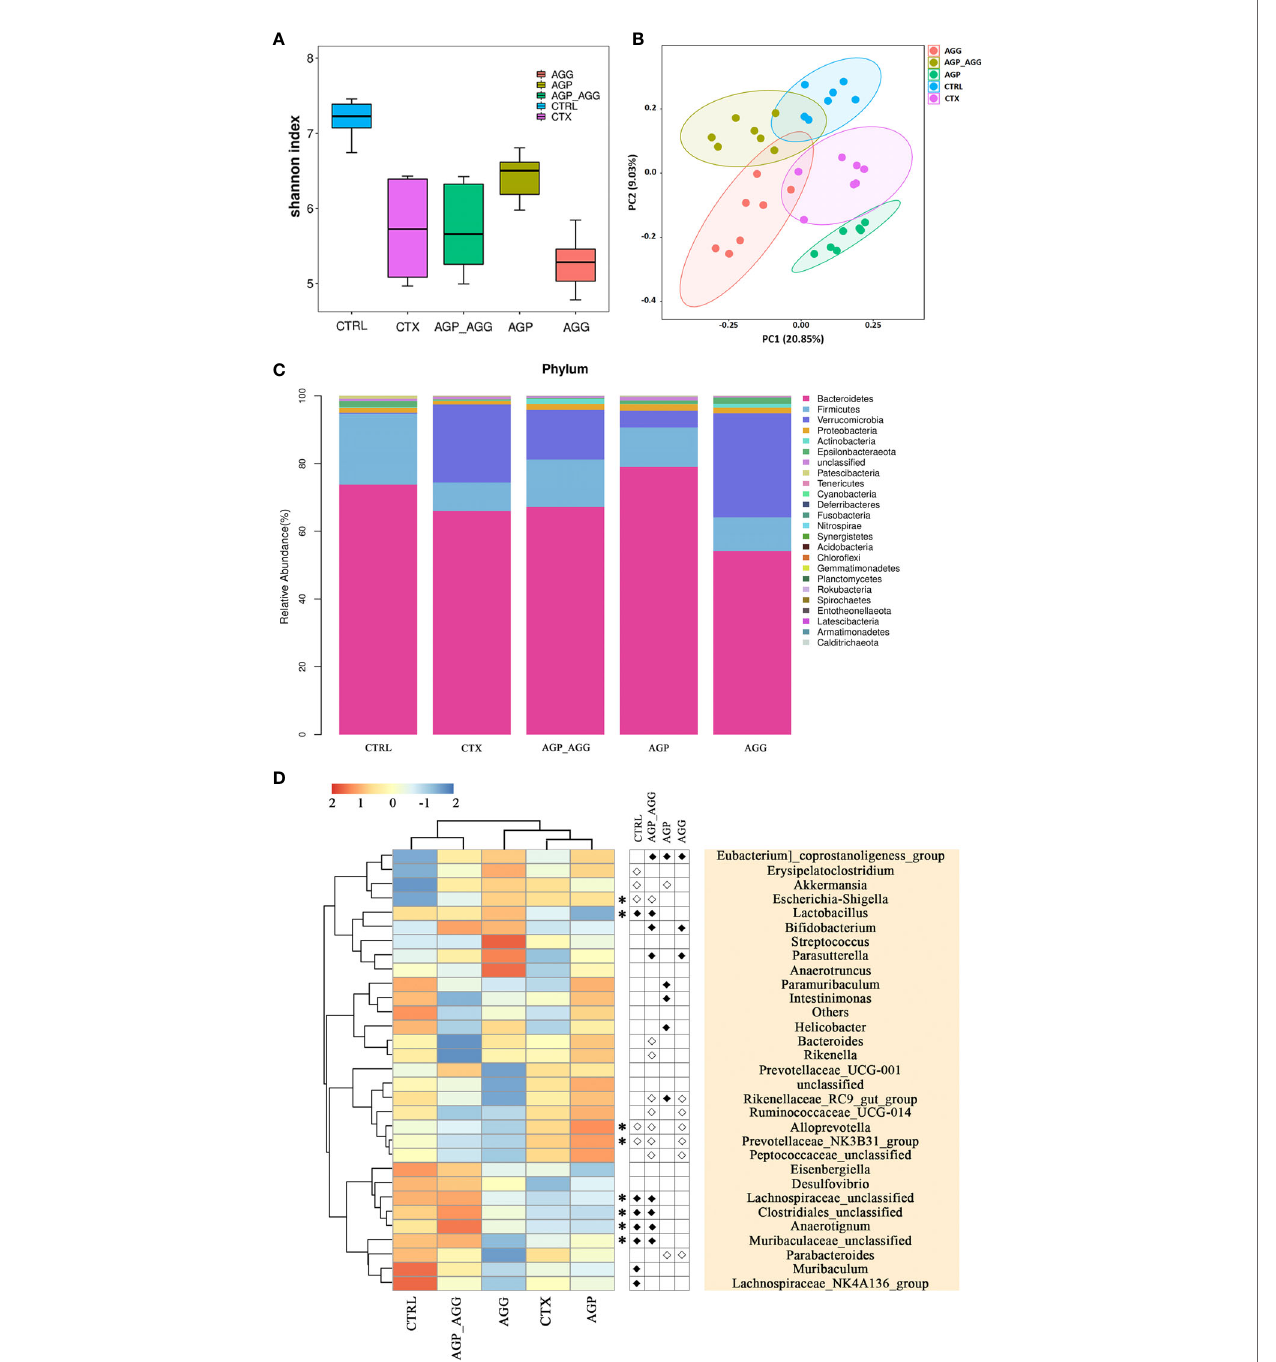
FIGURE 5 | AG treatments attenuated gut dysbiosis in CTX-induced mice. (n=7 for each group). (A) Alpha-diversity estimators by Shannon indexes. Data are expressed as mean with SD. (B) Unweighted UniFrac distance-based principal coordinate analysis. (C) Bacterial taxonomic pro fi ling at the phylum level. (D) Heat map of relative abundance of top 30 genus. In the middle panel, the differences of abundance distributions among genera between two groups were measured by the Wilcoxon rank-sum test, P < 0.05. White circles represent less abundant genera in CTRL, AGP_AGG, AGP, and AGG compared with CTX; Black diamonds represent more abundant genera in CTRL, AGP_AGG, AGP, and AGG compared with CTX. Asterisks represent genera whose abundance in CTRL mice was altered by CTX and then regulated by AGP_AGG. CTRL, control group; CTX, cyclophosphamide-induced immunosuppressive group; AGP_AGG, American ginseng polysaccharide+American ginseng ginsenoside with cyclophosphamide-induced immunosuppressive group; AGP, American ginseng polysaccharide with cyclophosphamide-induced immunosuppressive group; AGG, American ginseng ginsenoside with cyclophosphamide-induced immunosuppressive